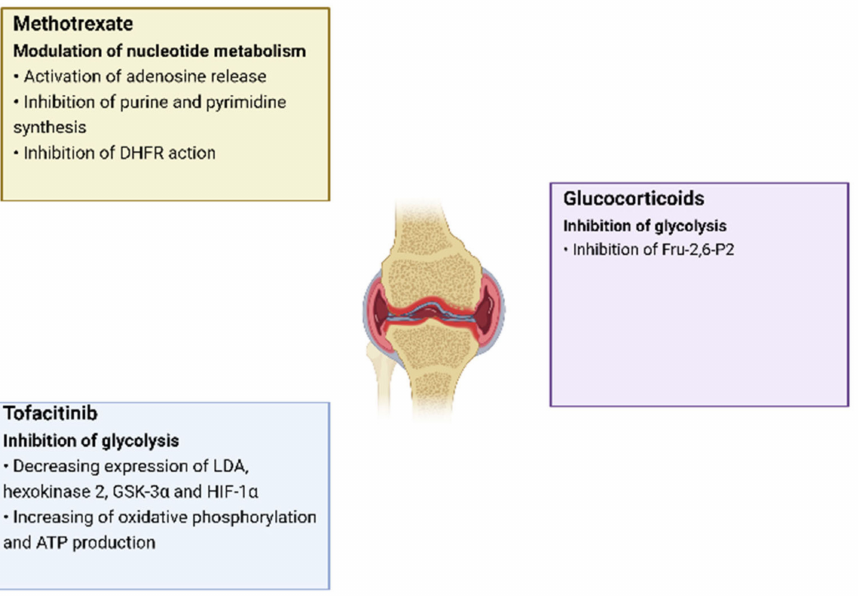
Figure 3. The effects of RA drugs on cell